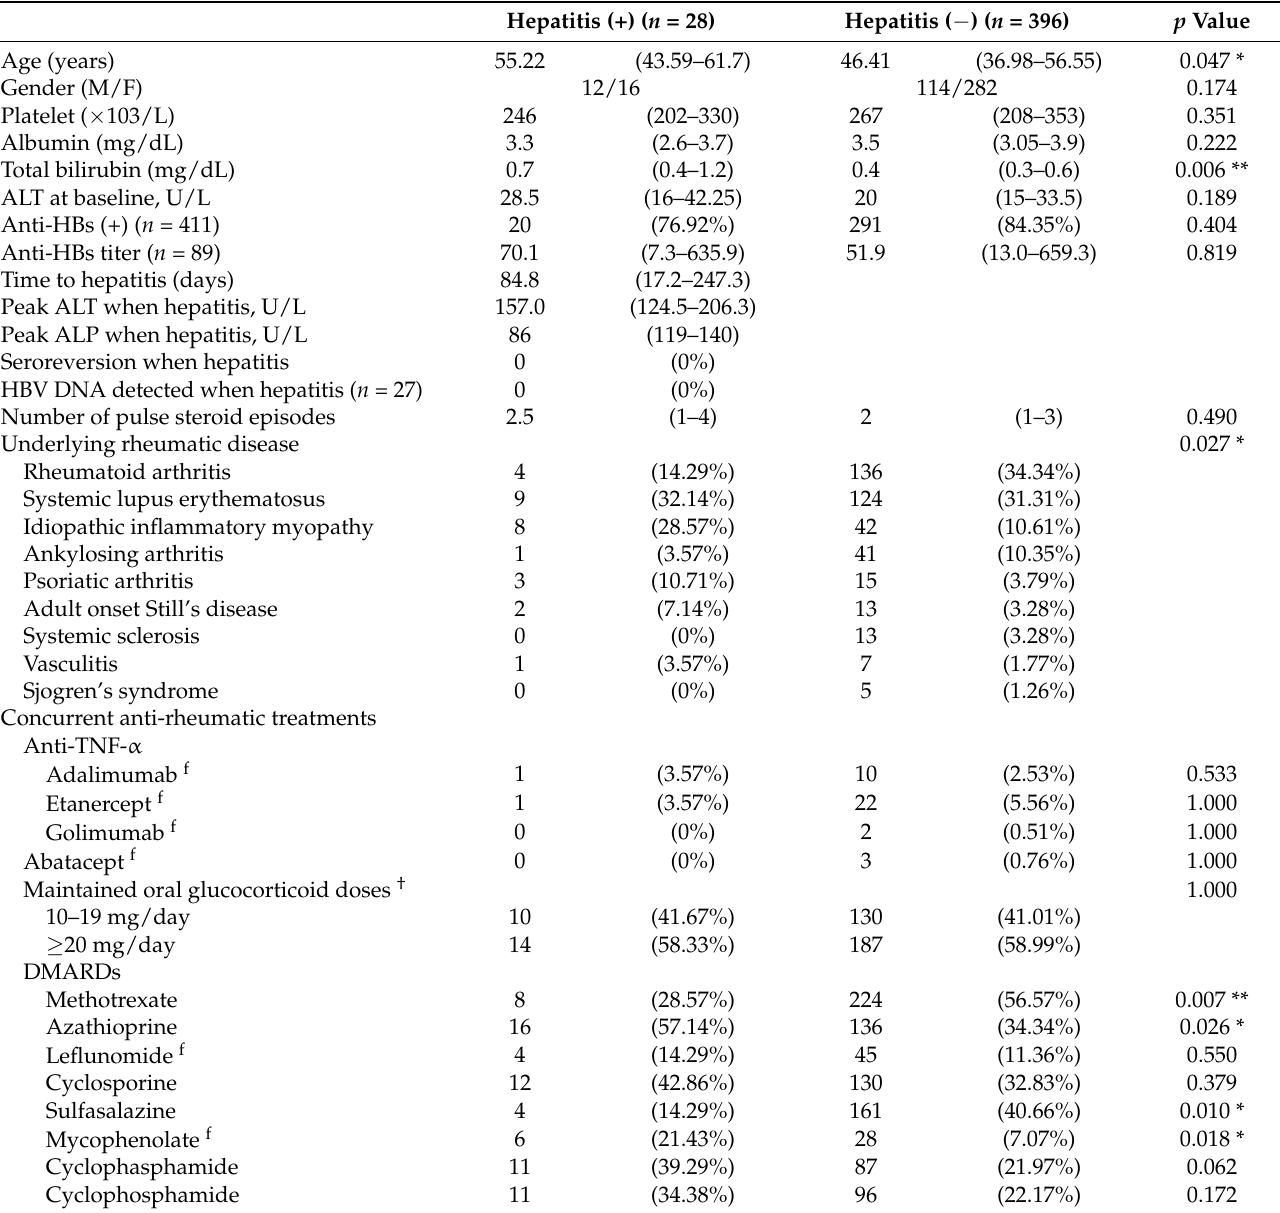
Table 2. Demographic characteristics of HBsAg-negative and anti-HBc-positive rheumatic patients receiving glucocorticoid pulse therapy with or without hepatitis within 1st